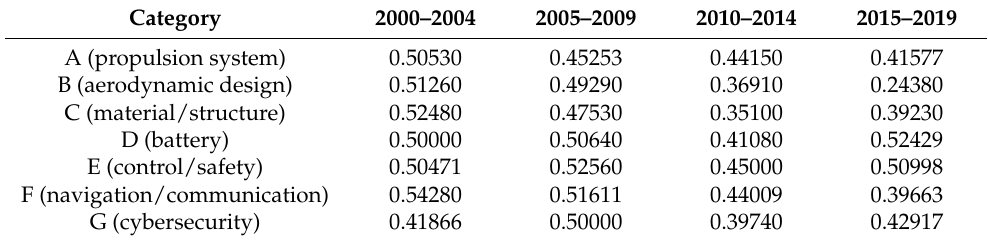
Table 15. Closeness centrality by